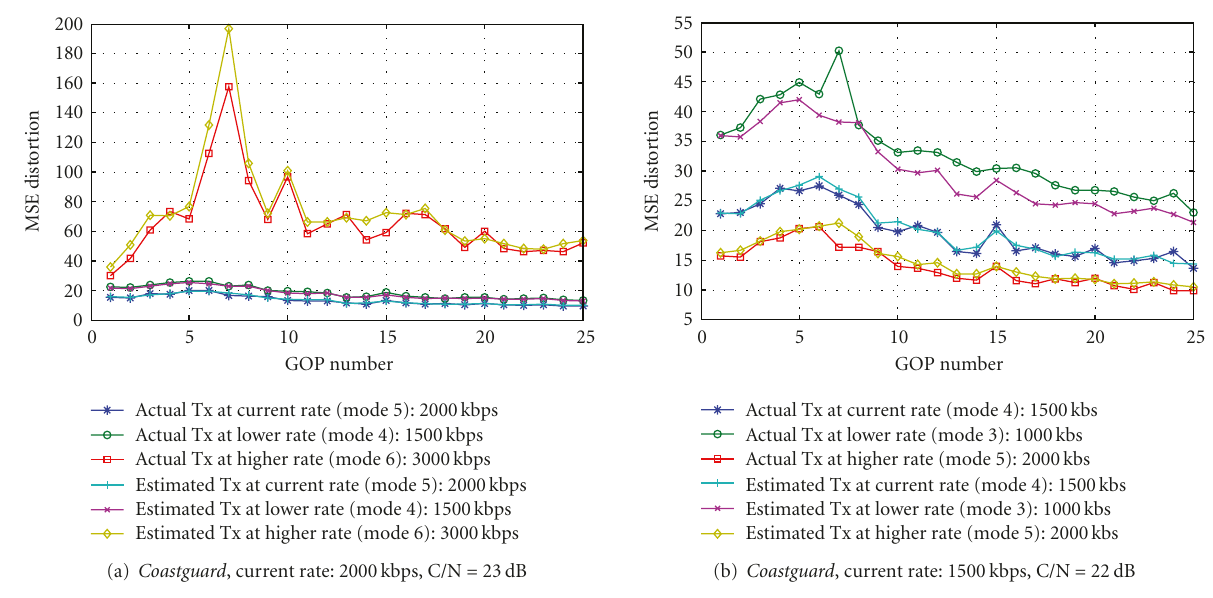
Figure 11: Comparison estimated and actual distortion for di ff erent power